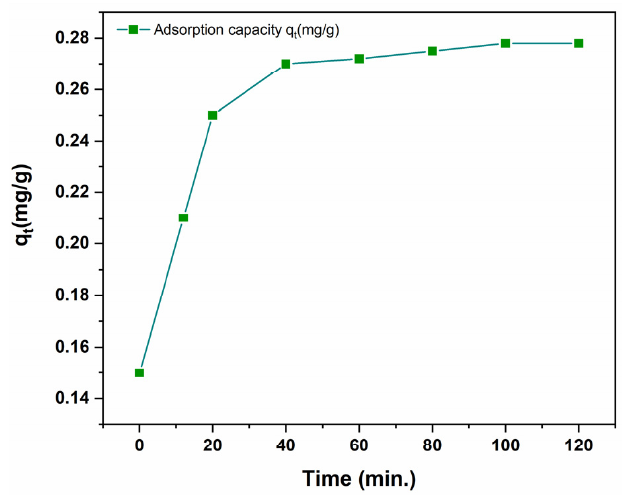
Figure 7. The impact of contact time on adsorption of Cr (III) 20 mg of C-PMMA/SnO 2 c at pH 6.0